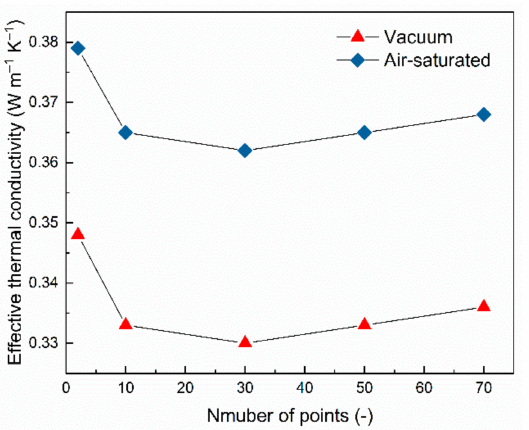
Figure 8. The effect of the number of seed points on the effective thermal conductivities of the RV